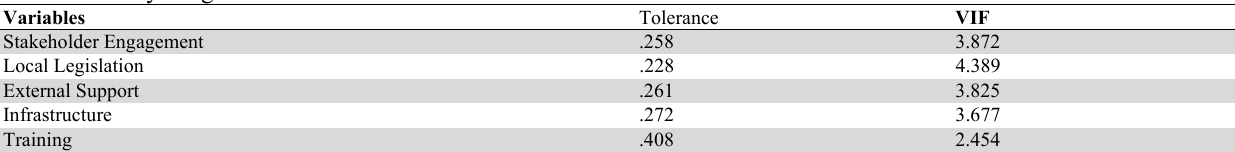
Multicollinearity Diagnoses